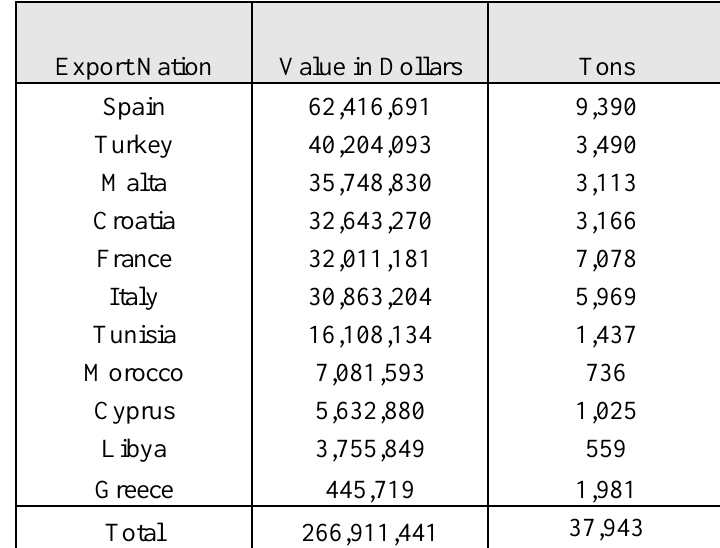
Table 2: Mediterranean Bluefin Tuna Exports. Average Estimated Values 9 and Quantity in Tons with Nation of Origin (2004-2005) (Bregazzi